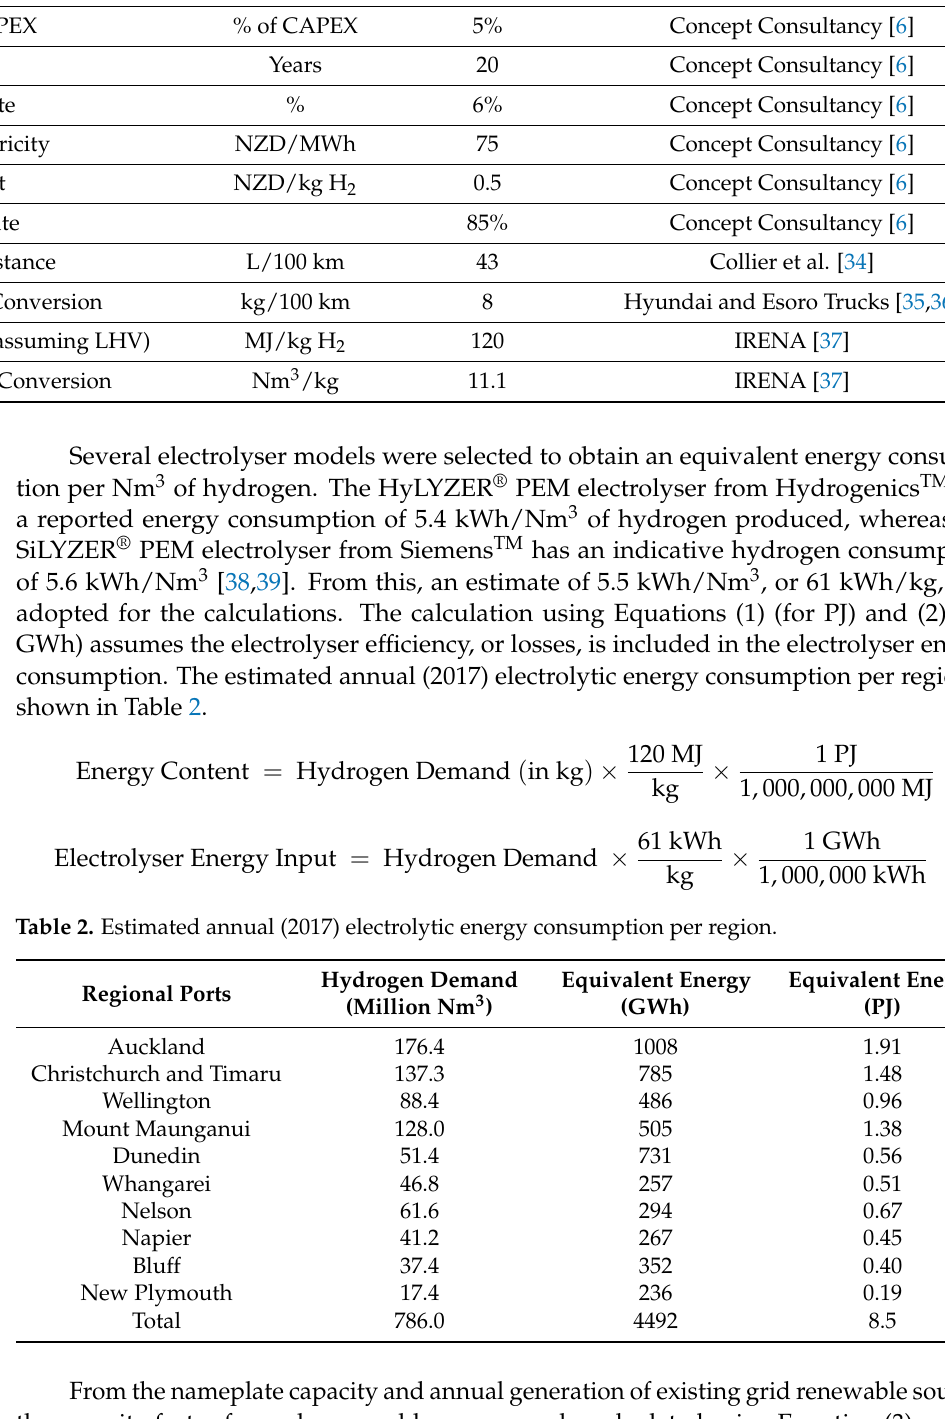
Table 3 details the consented yet unbuilt renewable energy capacity in each